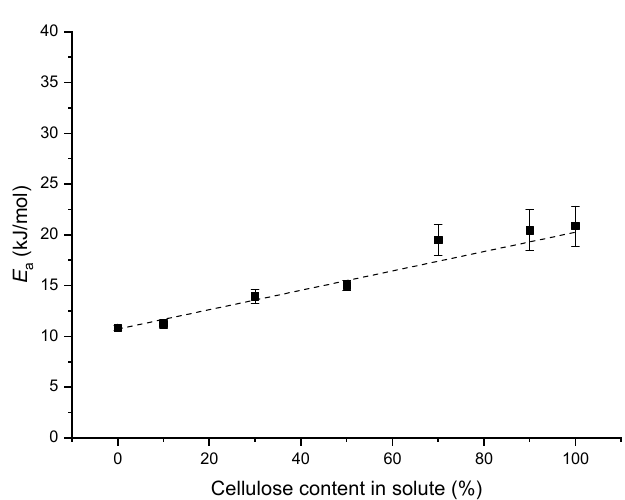
Figure 3. Activation energy ( E a ) of the starch/cellulose/ZnCl 2 solutions as a function of cellulose content in the solute. The total solute is 5 wt %, and the dashed line is a linear fit. Error bars represent standard deviations.